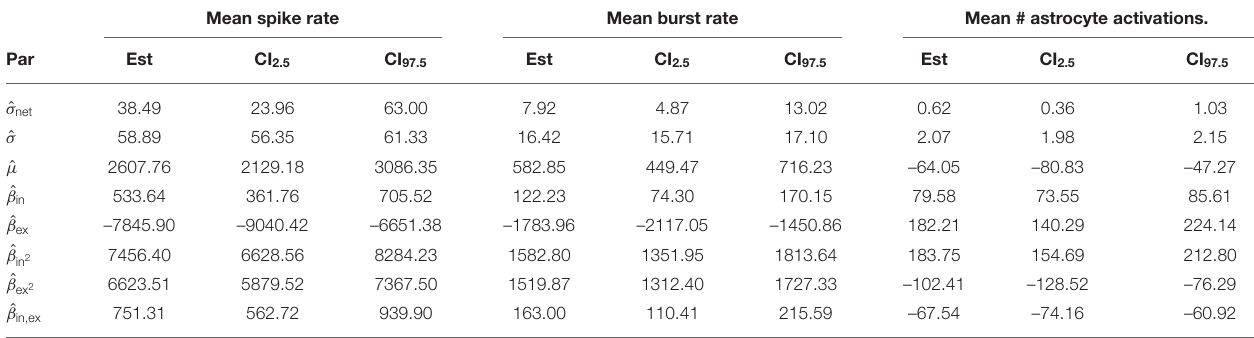
TABLE 6 | Restricted maximum likelihood estimates, lower and upper ends of 95 % confidence intervals for the synaptic weight parameter experiments. Mean spike rate Mean burst rate Mean # astrocyte